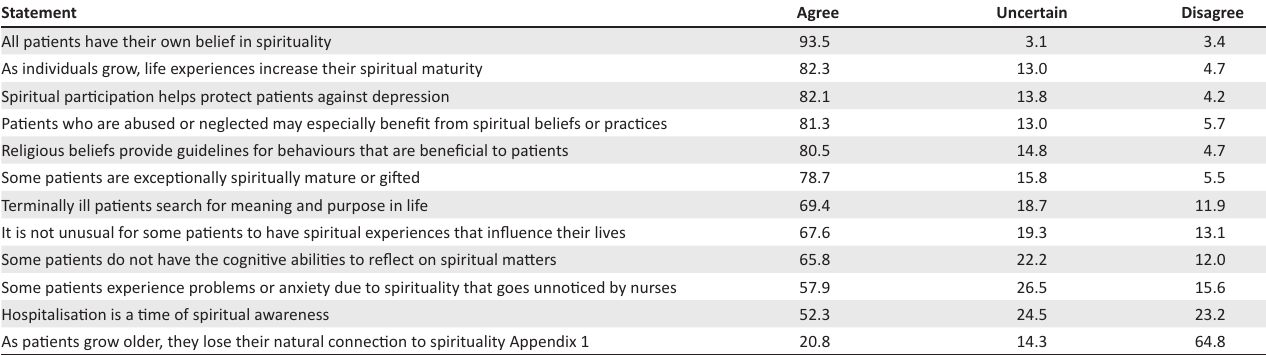
TABLE 1: Salience of spirituality to